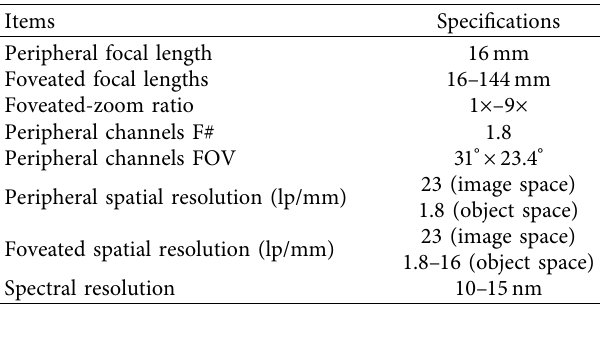
Table 1: Specifcations of a 9 ×